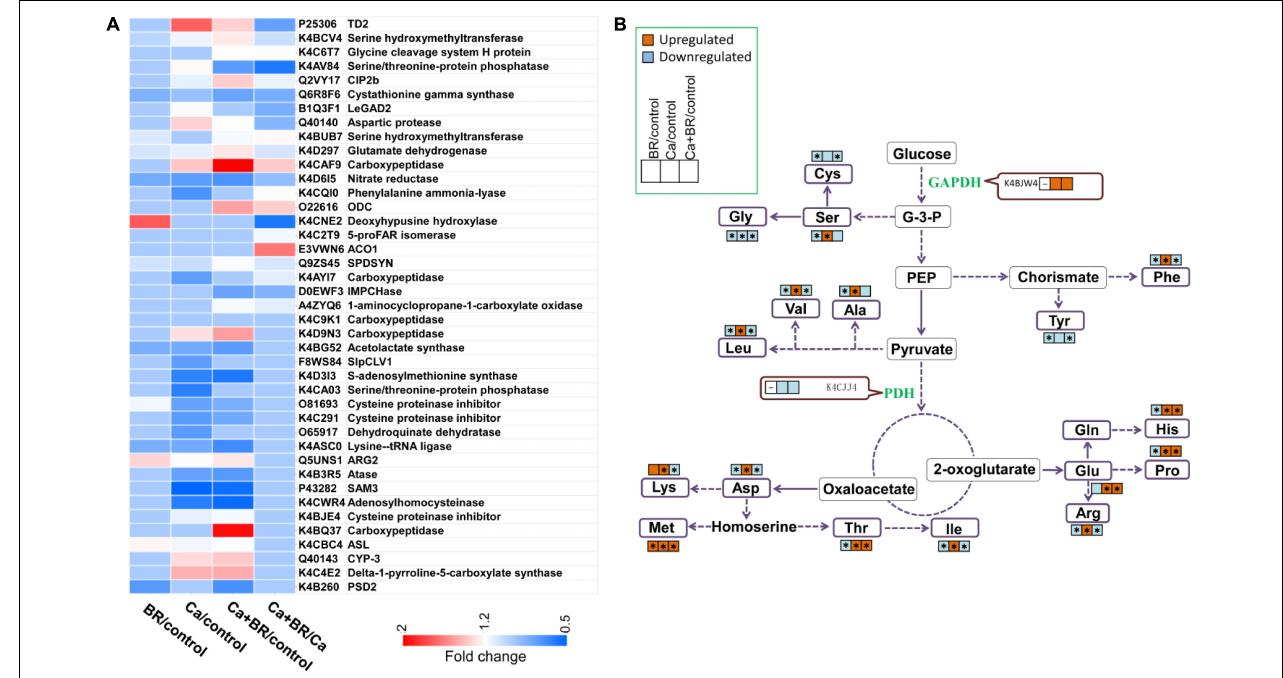
FIGURE 7 | Changes in the content of amino acids and enzymes involved in the glycolysis and TCA cycle. (A) Heatmap of the differentially changed proteins involved in amino acid metabolism. (B) Amino acids or the enzymes that showed significantly higher or lower accumulation in the leaves of tomato seedlings compared with those in the untreated control seedlings are represented by red (up-regulated) and blue (down-regulated) boxes. Asterisks indicate statistically significant differences ( P <